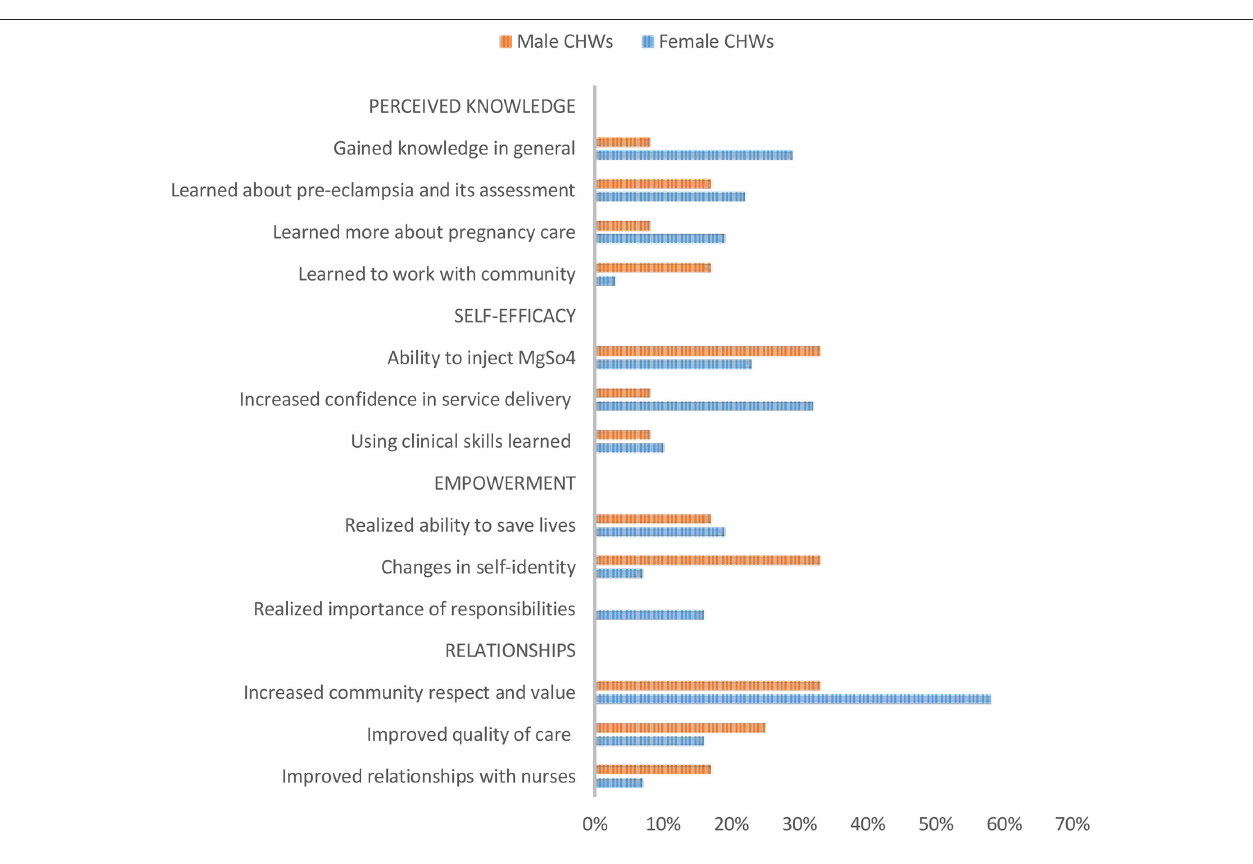
FIGURE 1 | Relative proportion of respondents mentioning key themes to describe impact of using mHealth app by